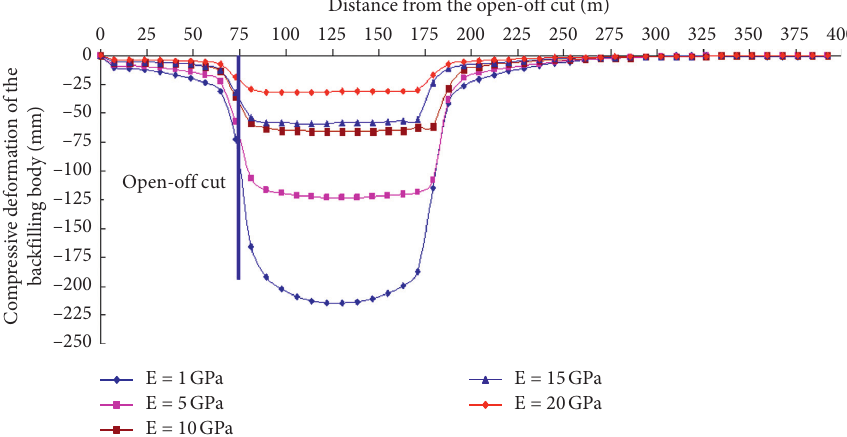
Figure 15: Compressive deformation of the backfilling